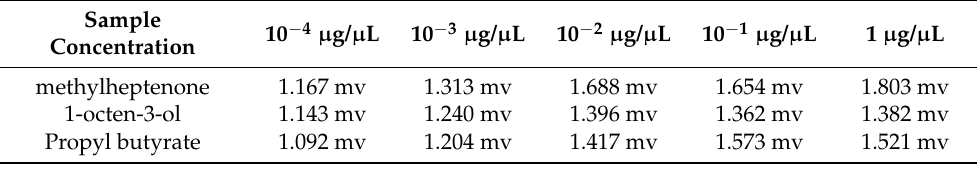
Table 4. EAG relative response value of male W. magnifica to different concentrations of three compounds.